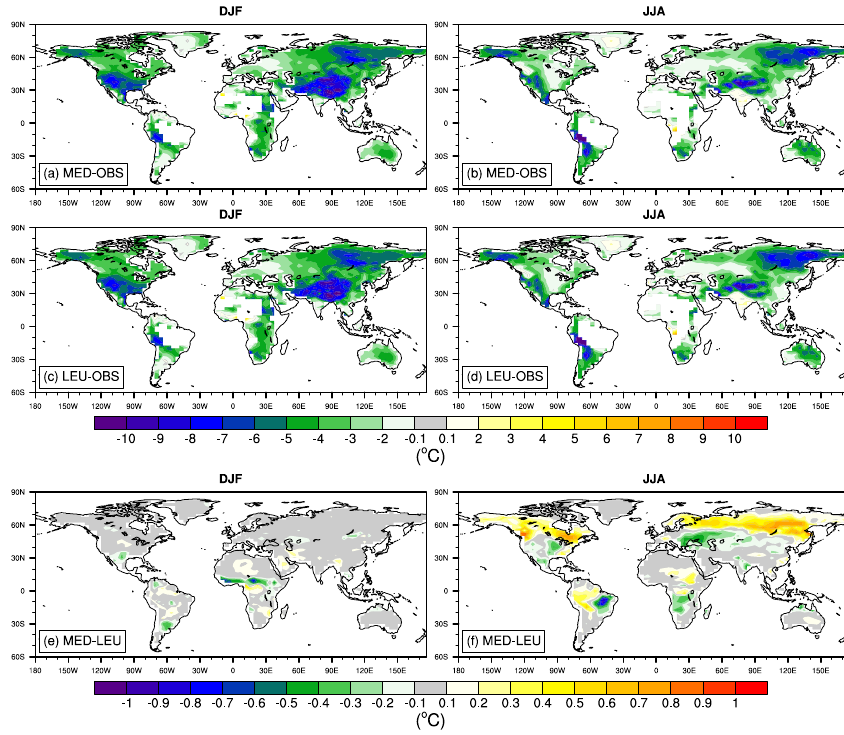
Figure 5. Same as in Fig. 4 except showing the diurnal temperature range (DTR) from the HadEX2 data